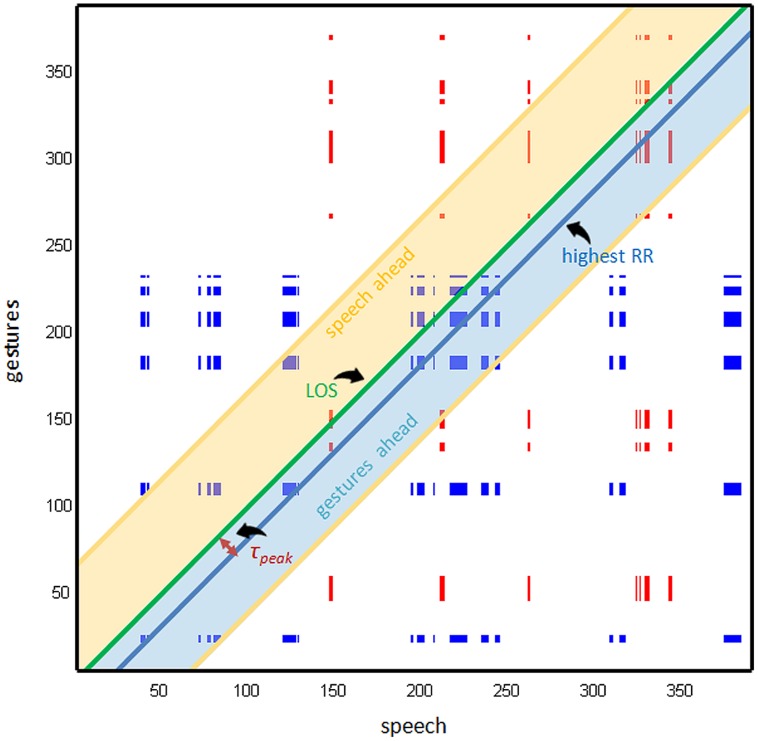
Cross recurrence plot (CRP) of one child (boy, 55 months).